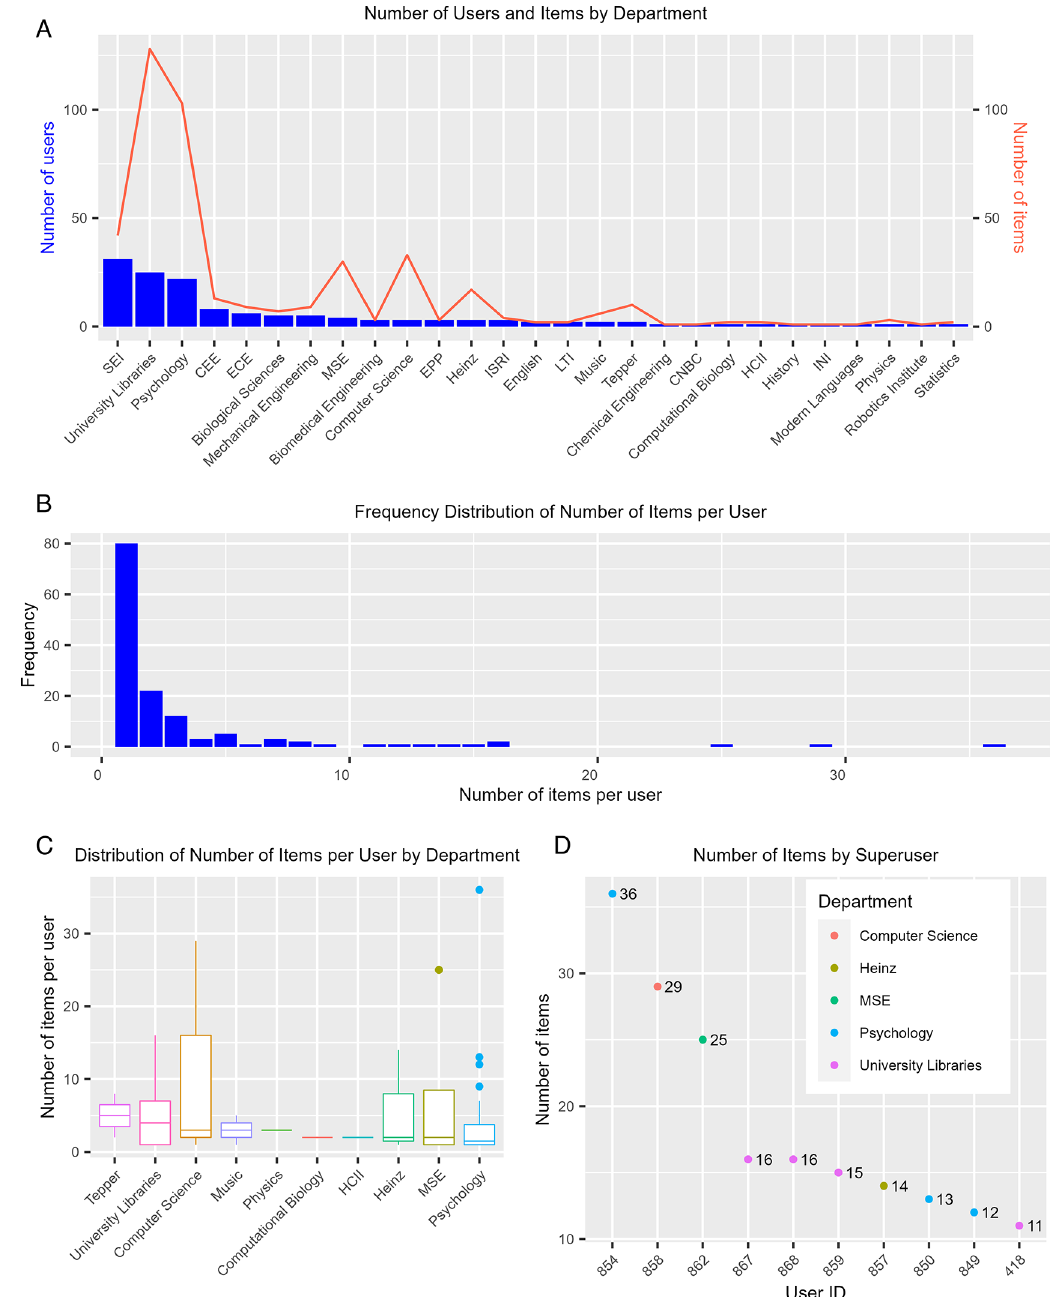
Figure 4. Summary of KiltHub use. (A) Departmental breakdown of number of KiltHub users (blue bars) and number of public items owned by users collectively in these departments (red line). (B) Frequency of number of public items owned per user (frequency is measured by the count of users with the specified number of public items owned). (C) Boxplot showing the distribution of the number of public items owned per user for the top 10 depart- ments, measured by mean number of items per user. The boxed area represents the interquartile range (IQR), with thelowerbarrepresentingthefirstquartile(Q1)value,theintermediatebarrepresentingthemedianvalue(Q2),and thetopbar representing thethirdquartile (Q3) value.The lines,or “ whiskers ” ,extending aboveand belowthe boxed area represent the range of values contained within 1.5 times the interquartile range (1.5 x IQR). Points extending beyond the whiskers represent outlier values (> 1.5 x IQR). (D) Number of public items owned for the 10 most active users (items > 10). These users are identified by their User ID (autonumber value assigned by Excel) to conceal